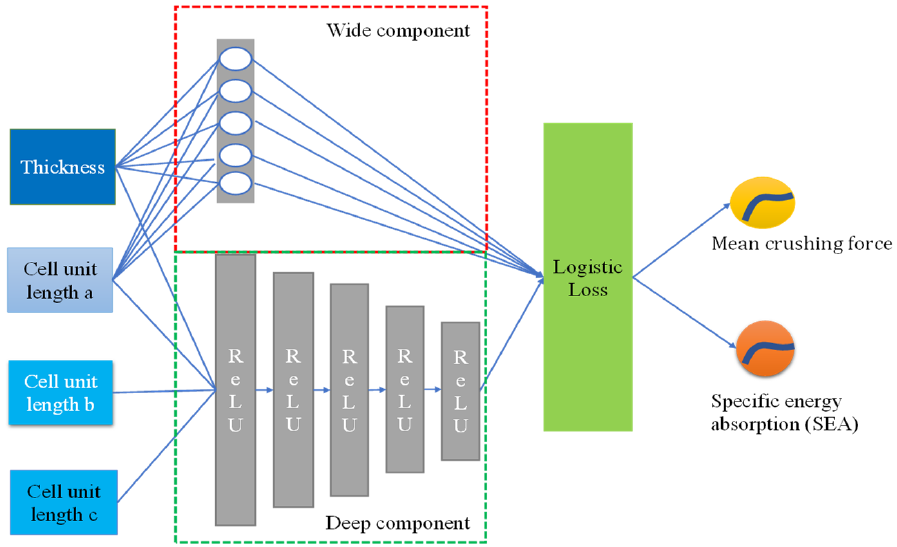
Figure 7. Deep learning framework.